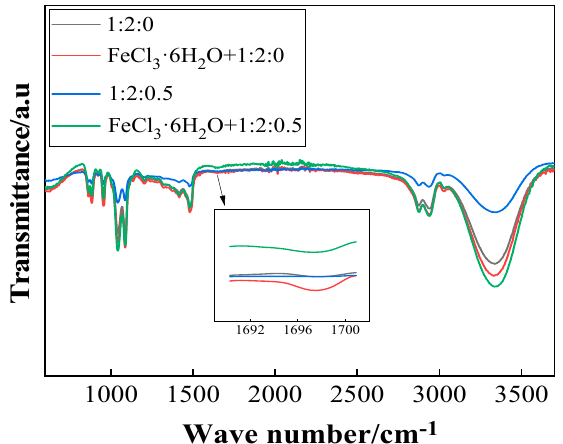
Figure 8. FT-IR spectra of the two different ratios of DESs without and with 0.1 mol·L − 1 FeCl 3 ·6H 2 O dissolved.